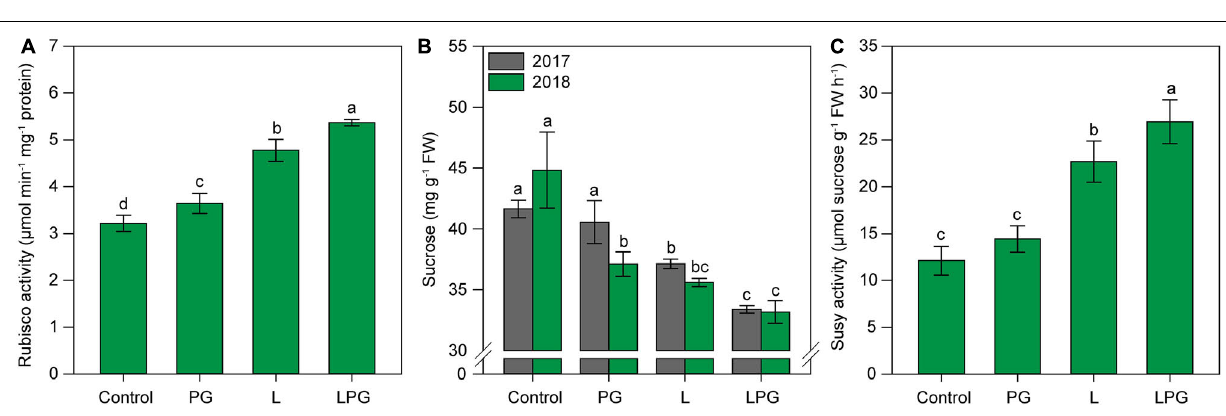
FIGURE 7 | Rubisco activity (A) , sucrose concentration (B) , and Susy activity (C) in maize leaves as affected by surface-applied lime (L), phosphogypsum (PG), and lime + phosphogypsum (LPG) treatments. Different lower-case letters indicate significant differences between treatments for each growing season by Student’s t -test at p ≤ 0.05. Error bars express the standard error of the mean ( n =